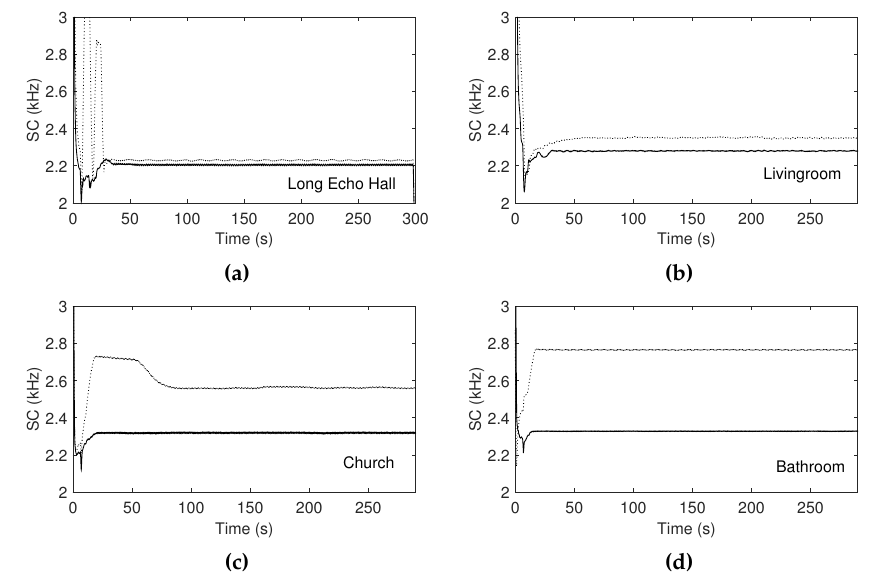
Figure 12. Spectral centroids measured using the impulse response data of ( a ) long echo hall, ( b ) living room, ( c ) church, and ( d ) bathroom. Solid curves represent unmodified signals, and dot curves represent output signals mixed with the output of the one-pole high-pass filter, where the mix ratio between the two signals is controlled depending on the estimated variances.